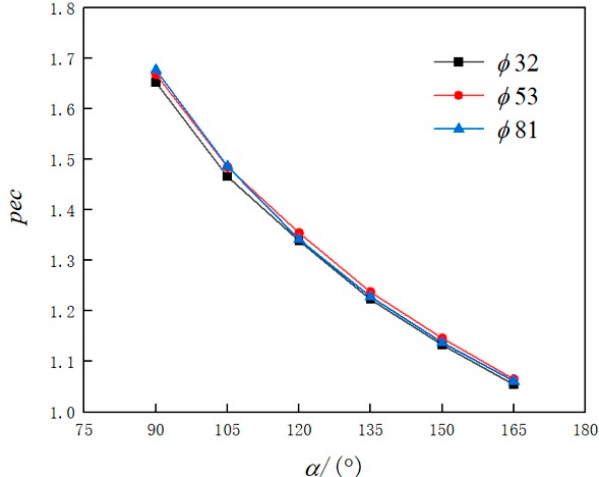
Figure 15. Comprehensive performance evaluation factor pec changing with the central angle α for helical pipes.